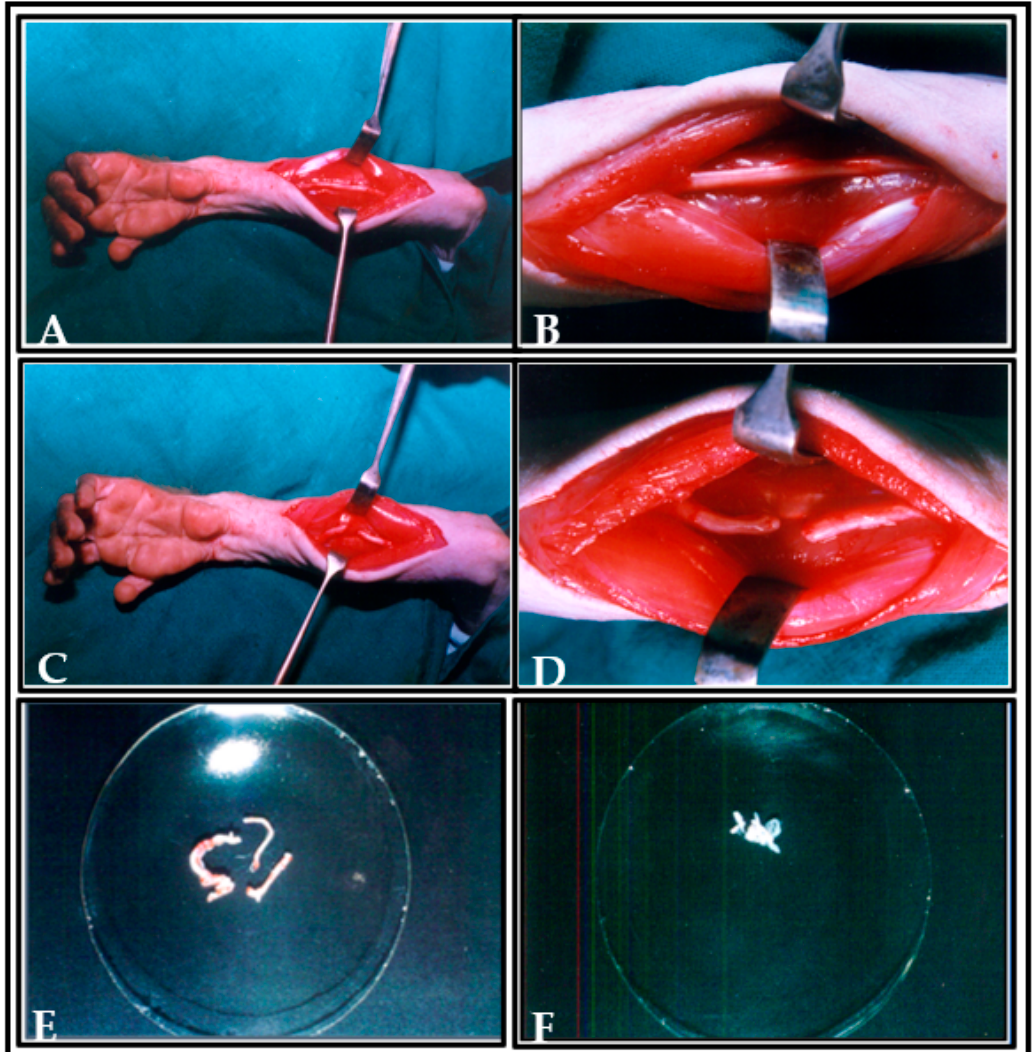
Figure 4. Photographs showing the preparation of ulnar nerve as donor tissue for transplantation. ( A , B ) Picture showing the incision made and the exposure of ulnar nerve. ( C , D ) Picture showing the ulnar nerve ligation. ( E ) Picture showing the ulnar nerve fascicles in dish. ( F ) Picture showing the transplanted predegenerated nerve fascicles in plasma clot at the hemisected cavity of spinal cord (arrow indicates the transplanted predegenerated nerve fascicles at the lesioned area of spinal